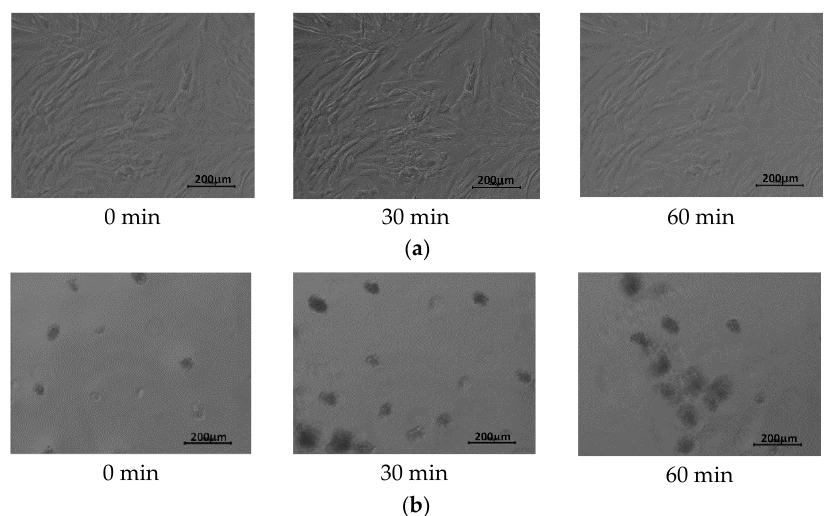
◦ C on: ( a ) TCPS; and ( b ) Film